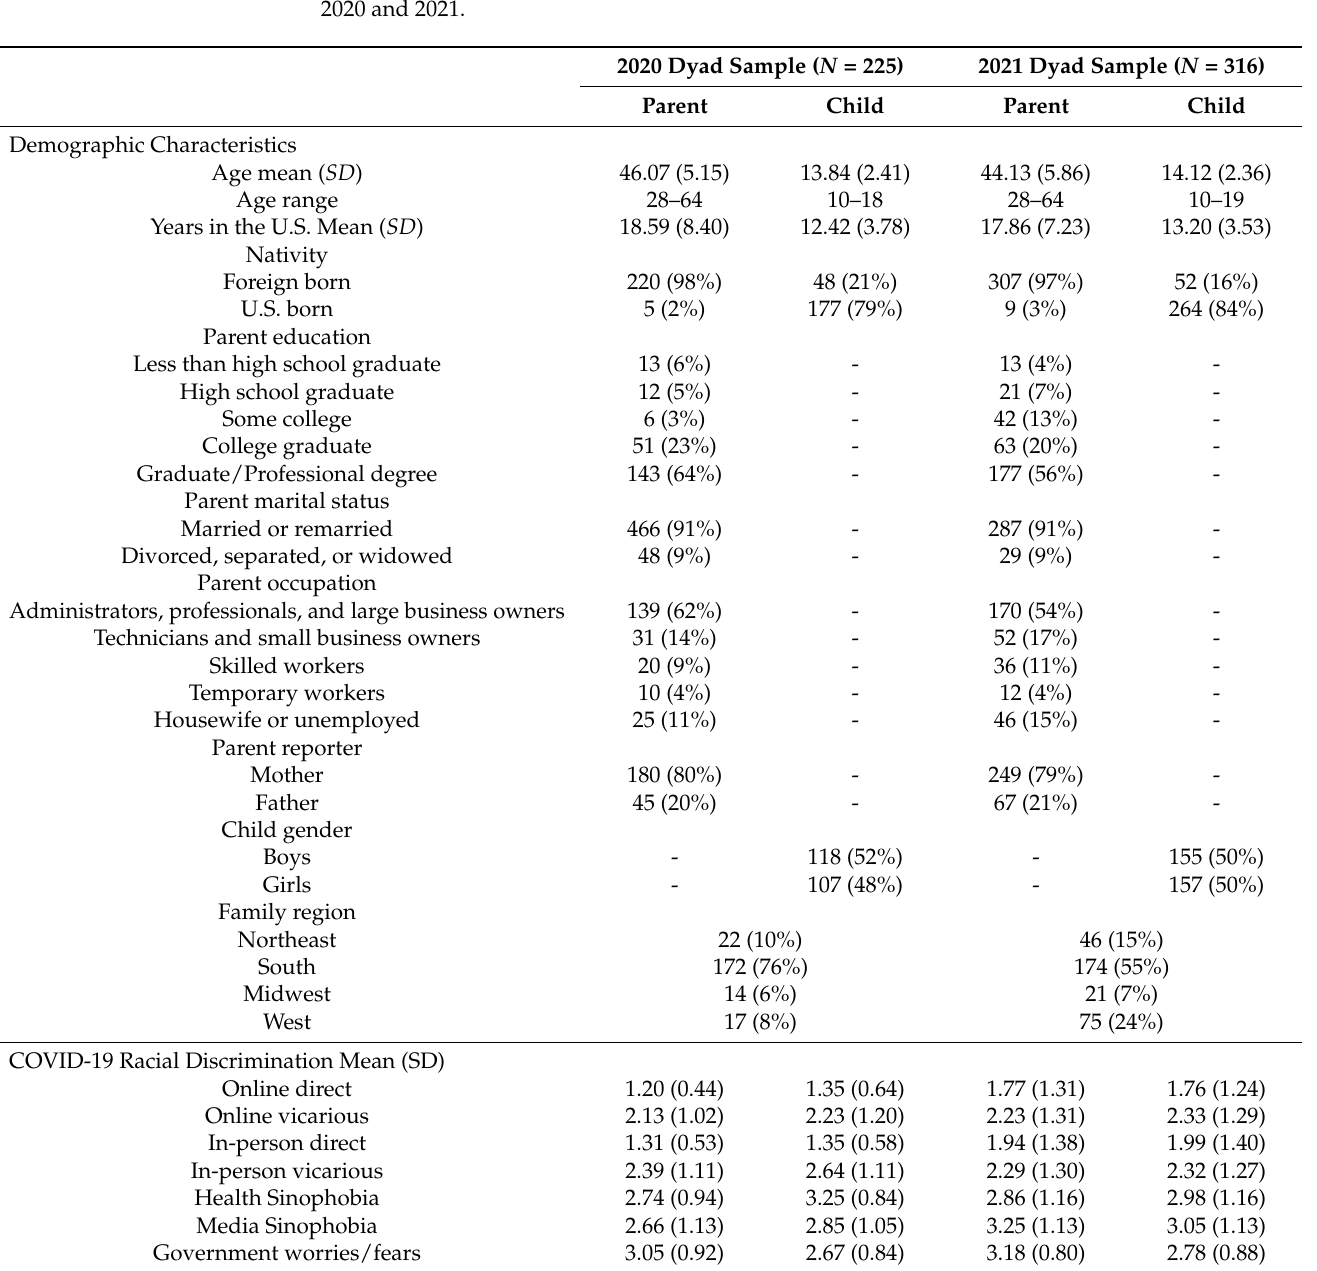
Table 2. Statistics of demographic characteristics and variables of interest in the dyad samples